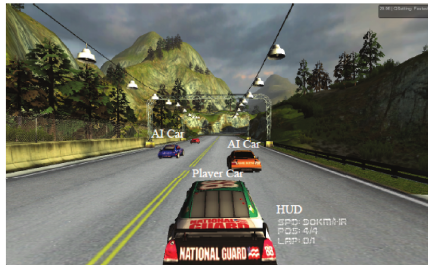
Figure 7: The game interface with indicators of the game compo-